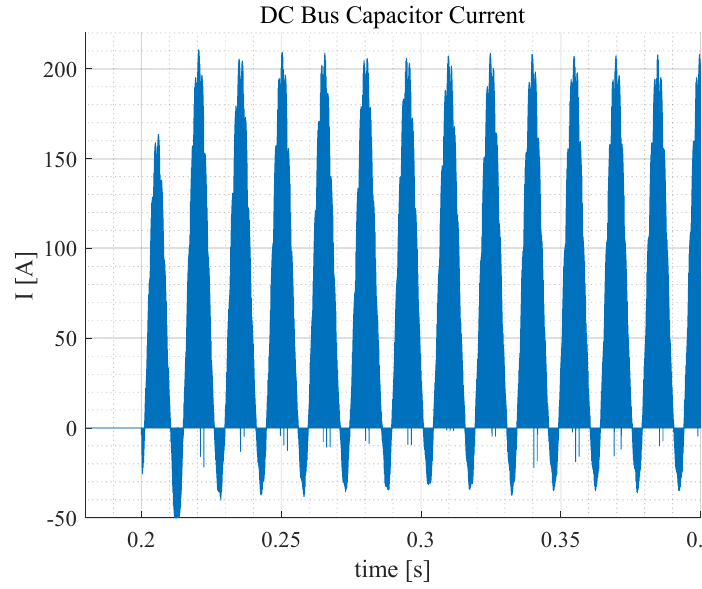
Figure 27. Time waveforms of DC-bus capacitor current.